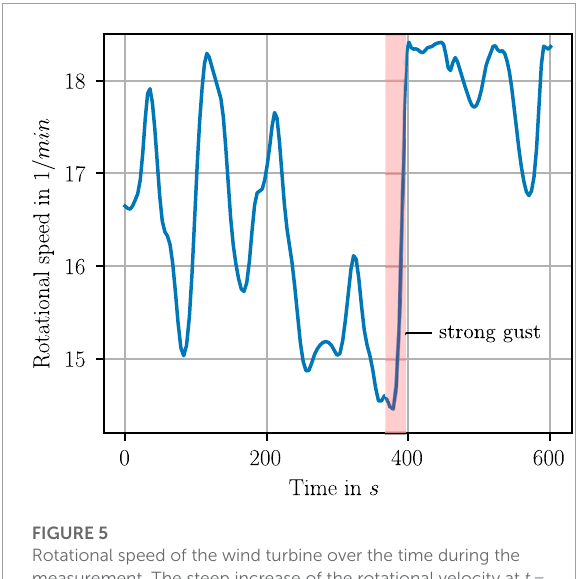
FIGURE 5 Rotational speed of the wind turbine over the time during the measurement. The steep increase of the rotational velocity at t = 390 s indicates the occurrence of a strong gust and, thus, a potential unsteady stall